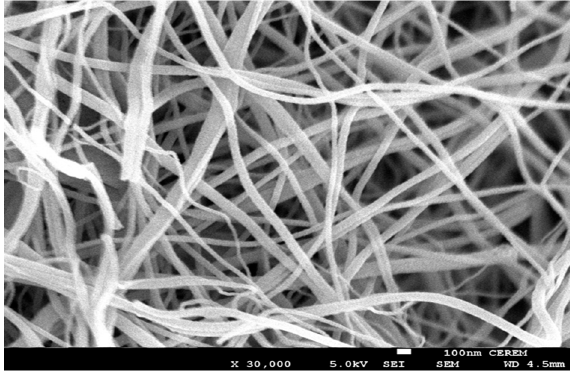
Figure 7. XRD patterns of the TiC calcined fiber at 1000  C under argon atmosphere.